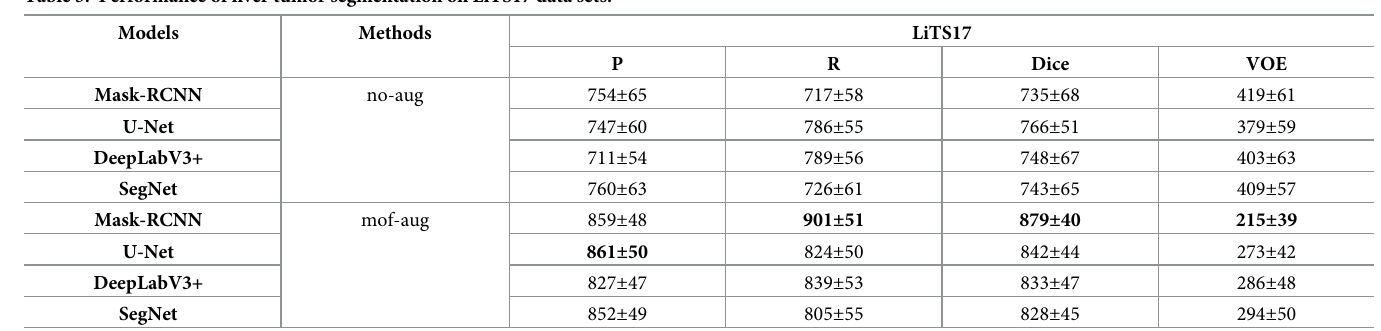
Table 3. Performance of liver tumor segmentation on LiTS17 data sets.